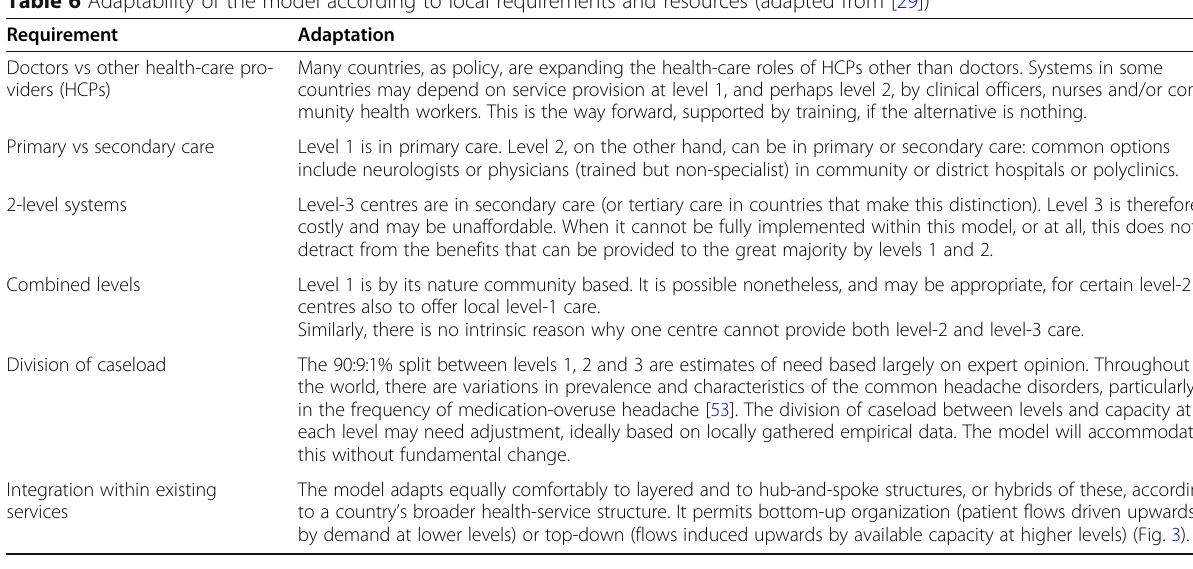
Table 6 Adaptability of the model according to local requirements and resources (adapted from [29]) Requirement Adaptation